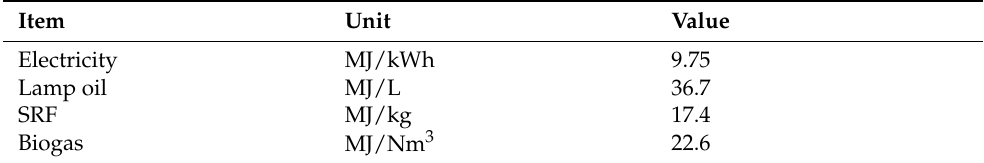
Table 10. Energy Conversion Index.